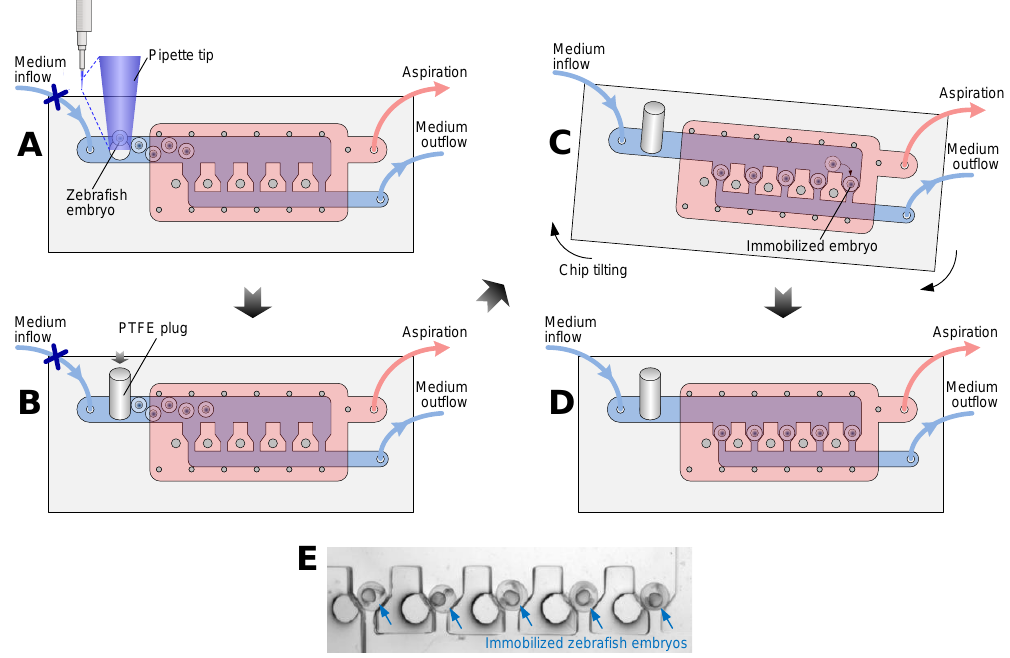
Figure 2. Operation process of the microfluidic device for embryo loading, trapping, and medium perfusion. ( A ) Loading embryos through the embryo inlet using a pipette. ( B ) Blocking the embryo inlet with the PTFE plug. ( C ) Tilting the device to roll embryos in the embryo-culturing channel and dock one embryo in each trap. ( D ) Retaining embryos in traps for culturing and real-time monitoring. ( E ) A micrograph showing five embryos immobilized in the device.